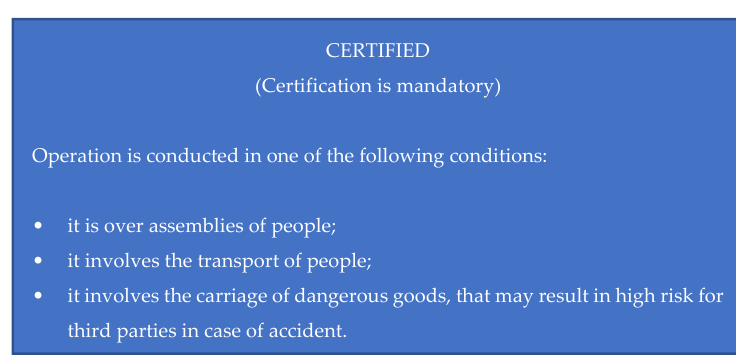
Figure 6. Constraints for the certified category.